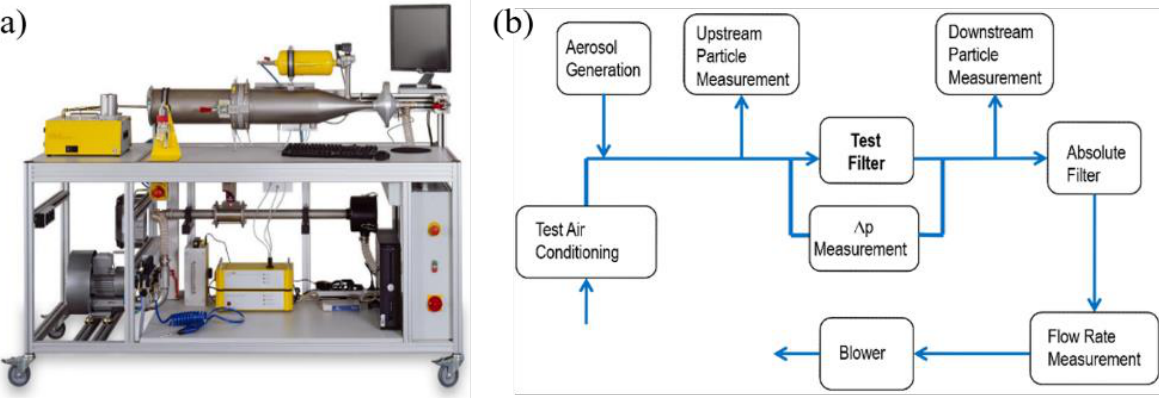
Figure 1. ( a ) The experimental device and ( b ) the schematic diagram of the filter media test rig.